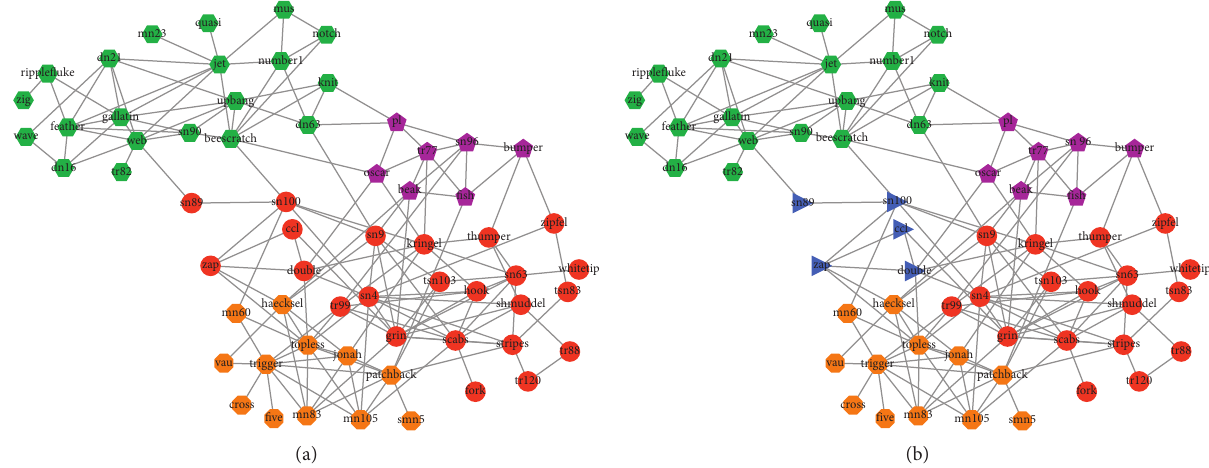
Figure 3: The dolphin social network. (a) The ground-truth community structure. (b) The community structure detected by our proposed method.